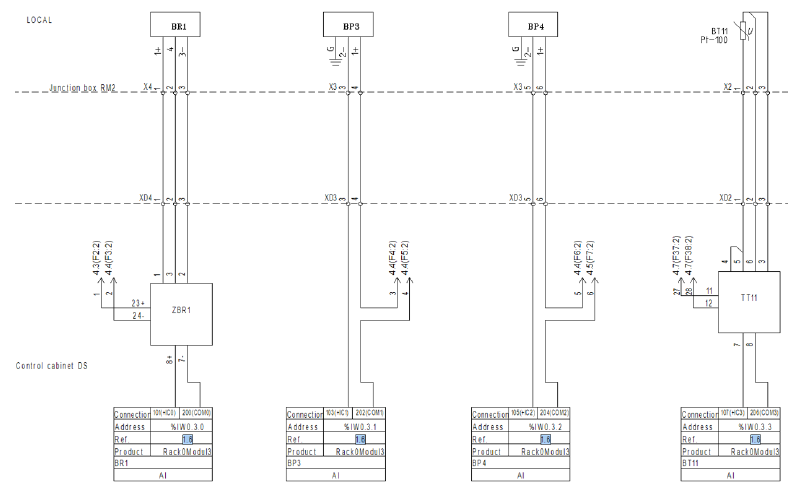
Figure 10. Automation loops of pressure sensors BP3 and BP4, rotation sensor BR1, and temperature sensor on the motor crankcase BT11.